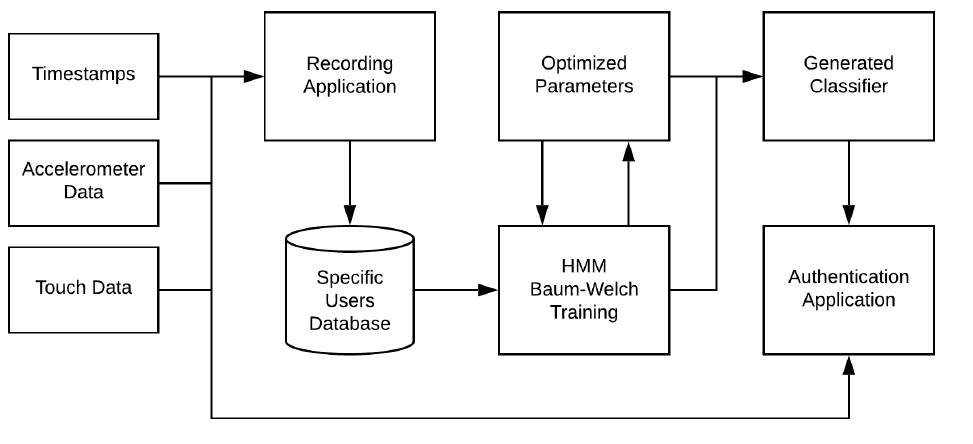
Figure 1. High Level Architecture of the